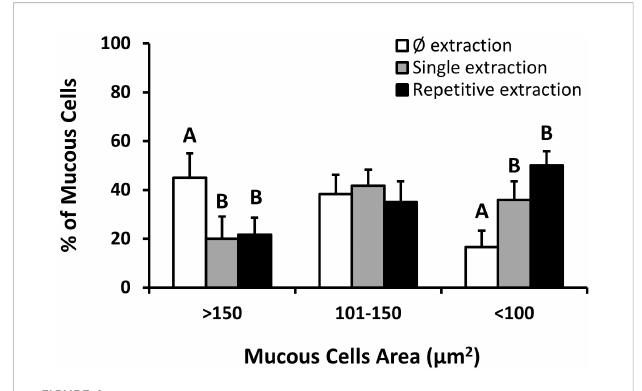
FIGURE 4 Mucous cell grouping by cell area. Data correspond to the mean percentage ± standard error of the mean (SEM) of the mucous cells of fi sh skin with: Ø skin mucus extractions (white bars), a single skin mucus extraction (gray bars), and repetitive skin mucus extractions (black bars). Letters indicate signi fi cant differences between no extractions (ØEG), a single extraction (SEG), and repetitive extractions (REG) (one-way ANOVA; N =